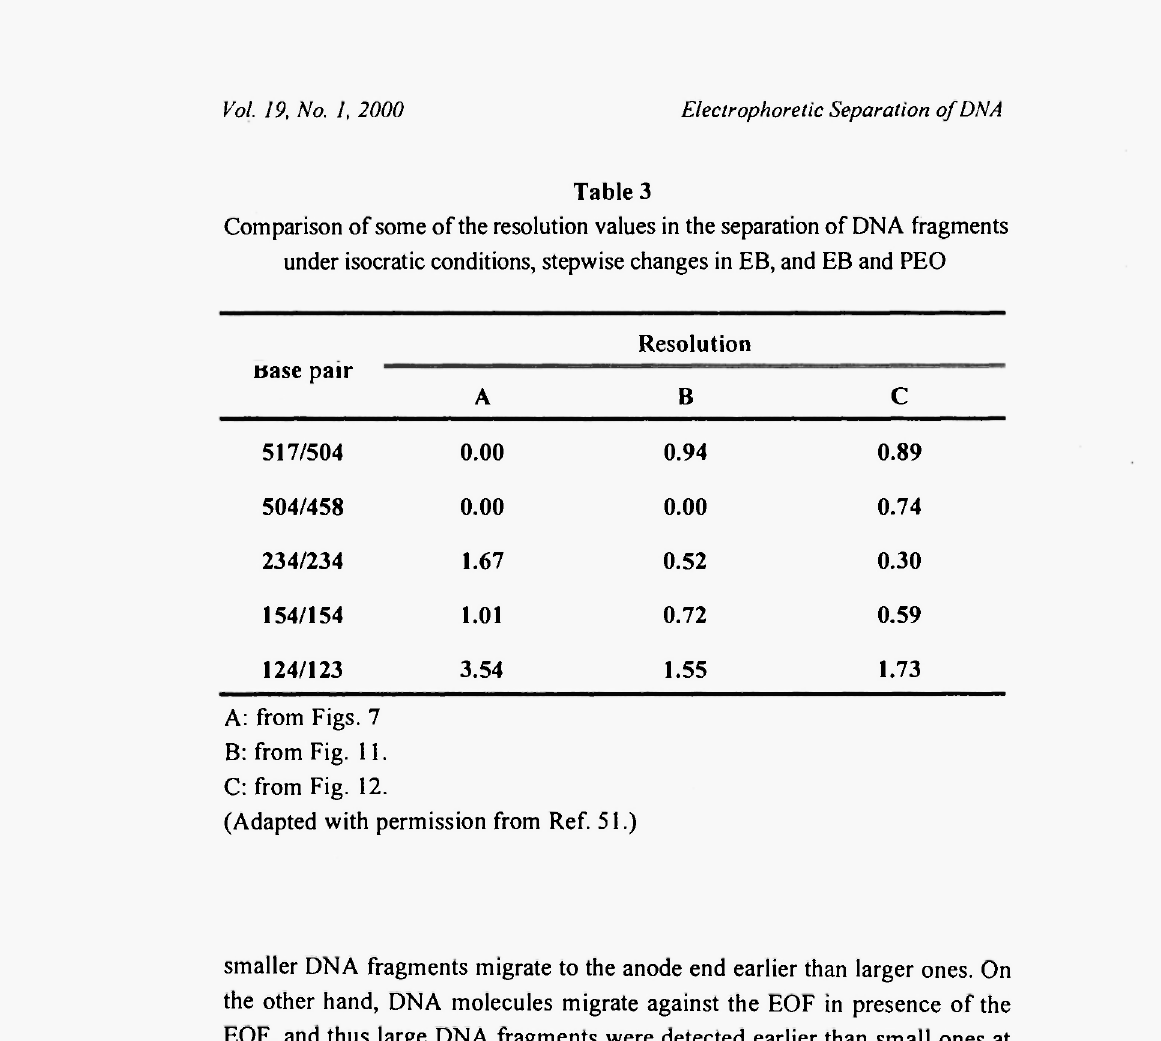
Comparison of some of the resolution values in the separation of DNA fragments under isocratic conditions, stepwise changes in EB, and EB and